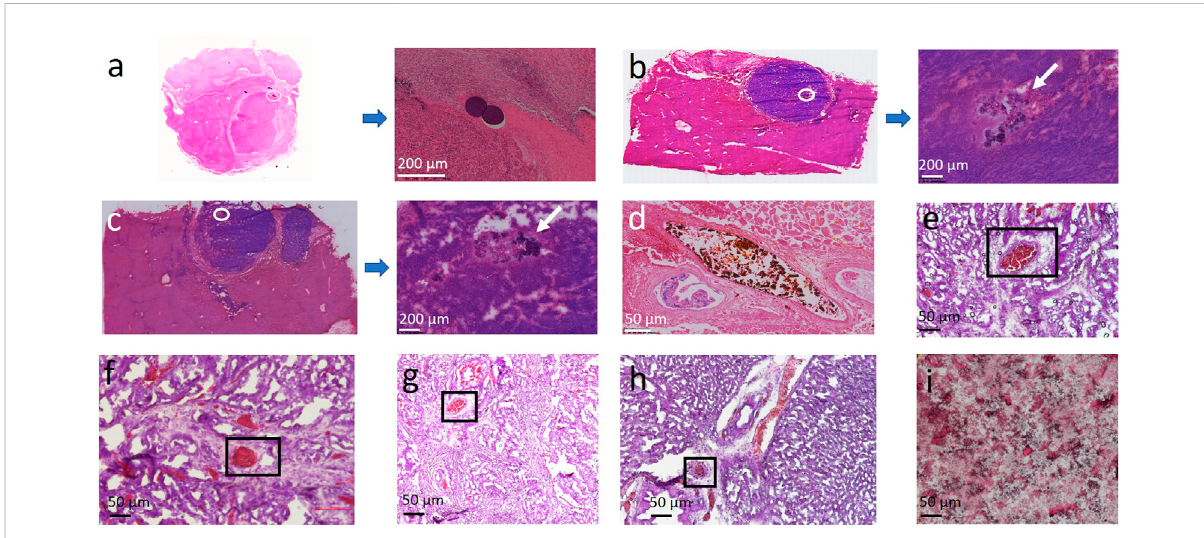
FIGURE 3 (A) RepresentativeslicesofcommercialbeadtrappedVX2carcinoma. (B,C) RepresentativeslicesofsevelamertrappedVX2carcinomaandtheir localmagni fi cations1and24 haftertheprocedure. (D,E) Somesevelamerparticleswereaggregatedwithinthebig (D) orsmallvessels (E) duetotheir deformability. The vessels with a size around or below 40 µm are also found to be fully embolized by the aggregates (F – H) . Hematoxylin-eosin staining of pure sevelamer was set as control (I)